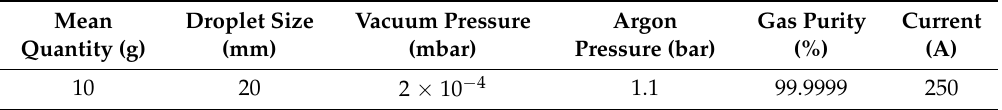
Table 2. Arc-furnace